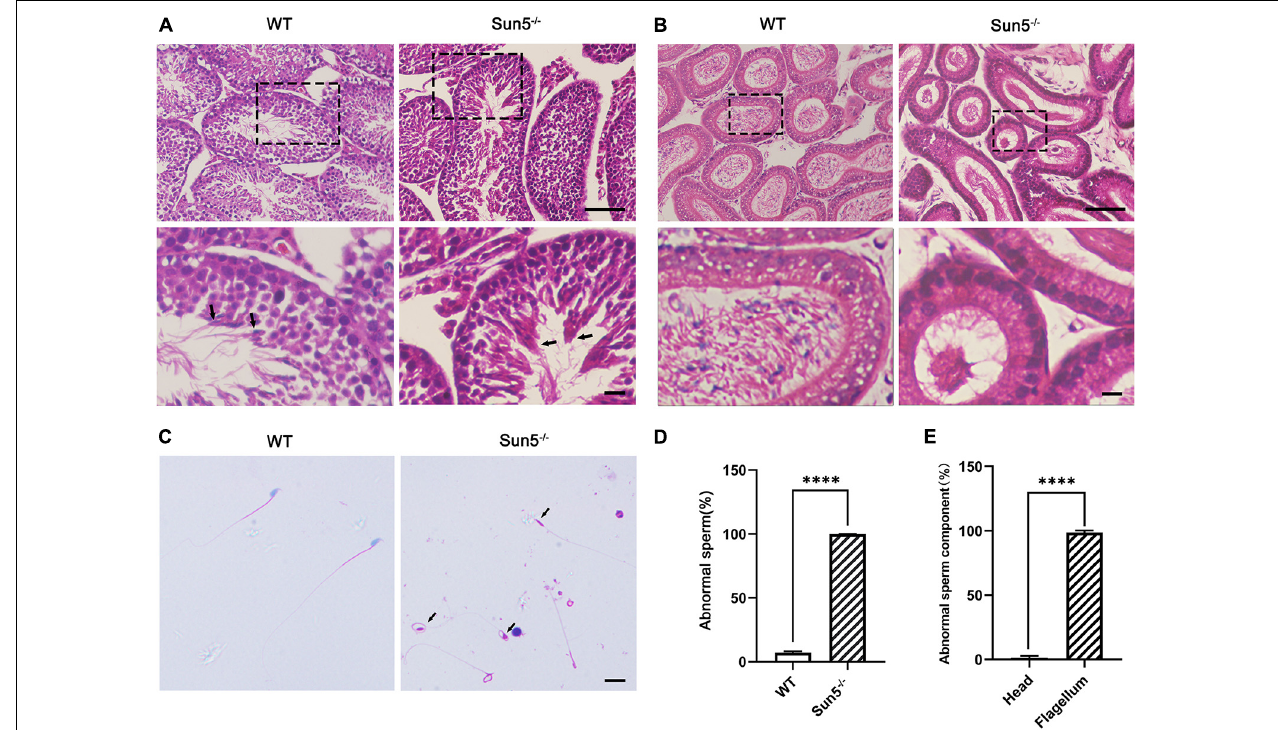
FIGURE 2 | Sun5 deficiency leads to decapitated sperm in Sun5 − / − mice. (A,B) Histological HE staining of WT and Sun5 − / − testes (A) and epididymis (B) . The arrows indicate the spermatozoa near the lumen of the testis. Bars: upper panel, 100 µ m; lower panel, 50 µ m. (C) HE staining of epididymal sperm smears showing decapitated sperm in Sun5 − / − mice. The arrows indicate the remaining cytoplasmic droplets. Bars: 50 µ m. (D,E) The percentage of abnormal sperm in WT and Sun5 − / − mice (D) and the percentage of abnormal sperm components in Sun5 − / − mice (E) . Data are presented as the mean ± SEM, n = 3. ∗∗∗∗ P <